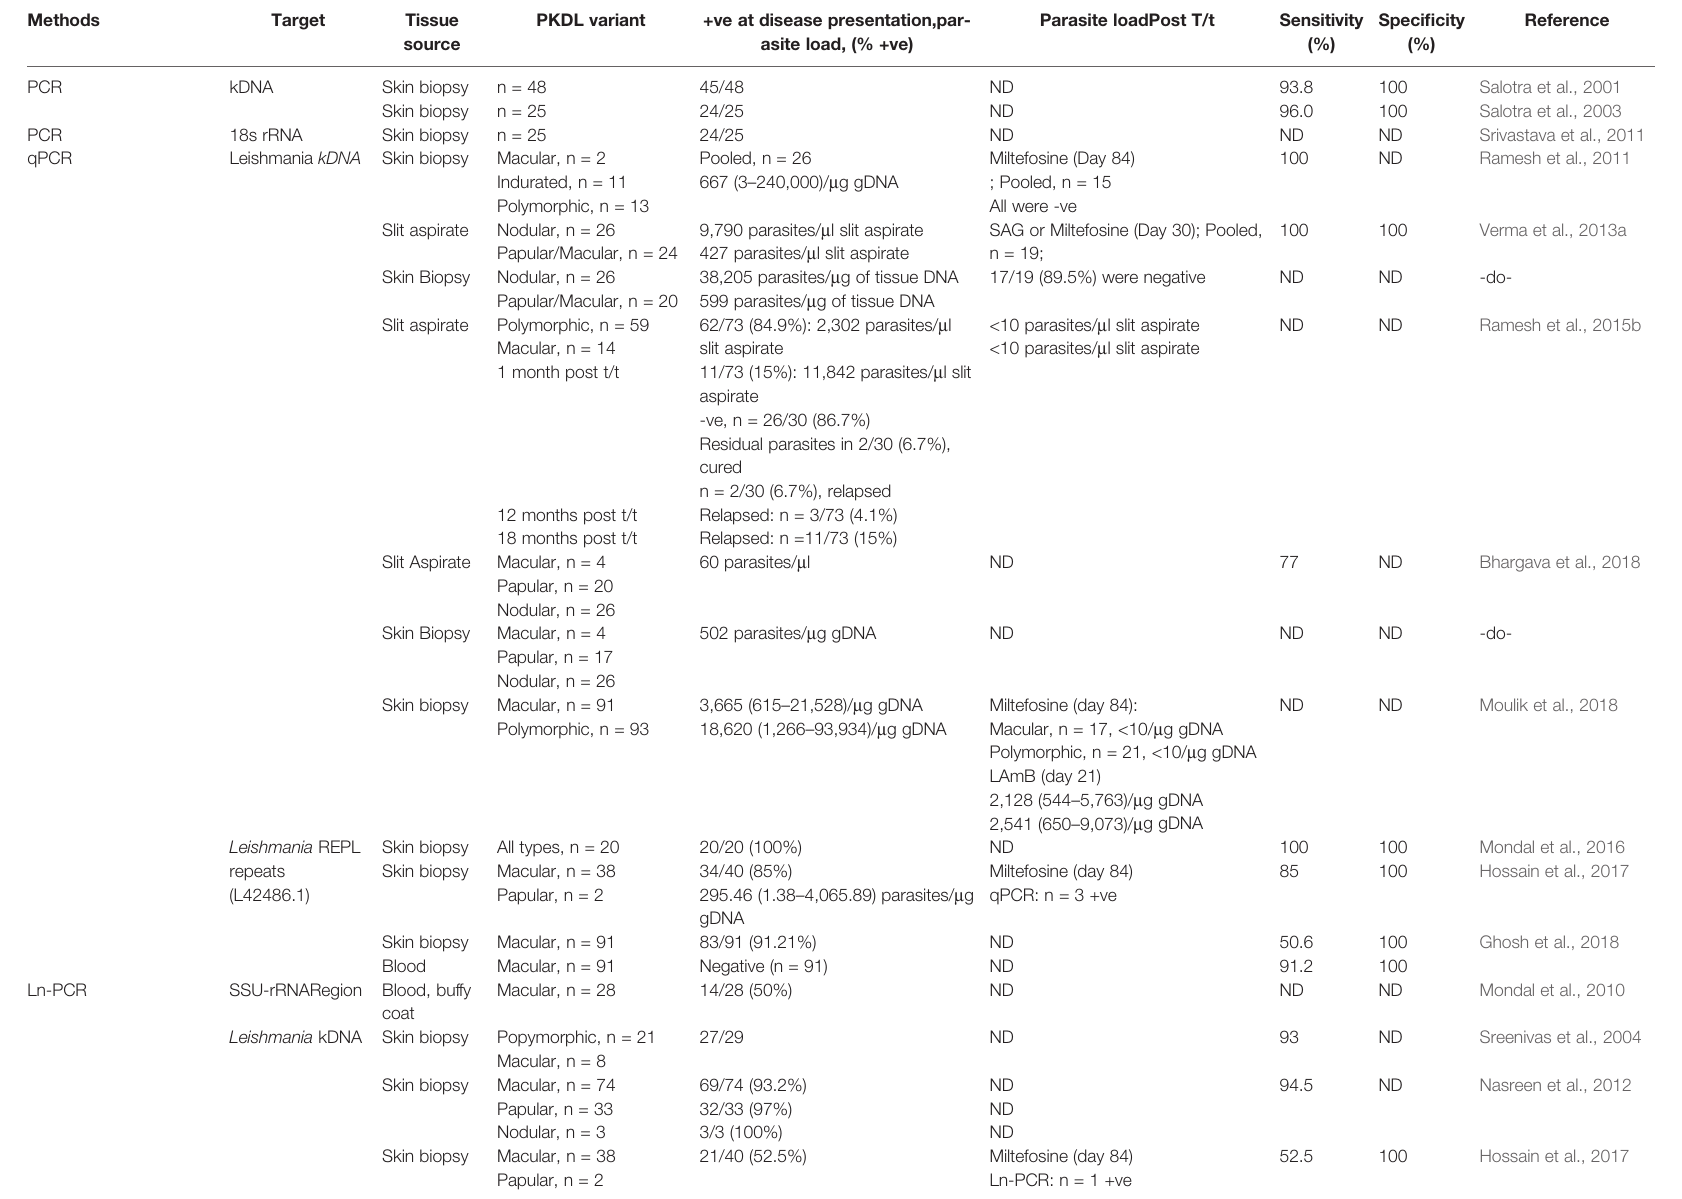
TABLE 5 | Nucleic Acid Markers of